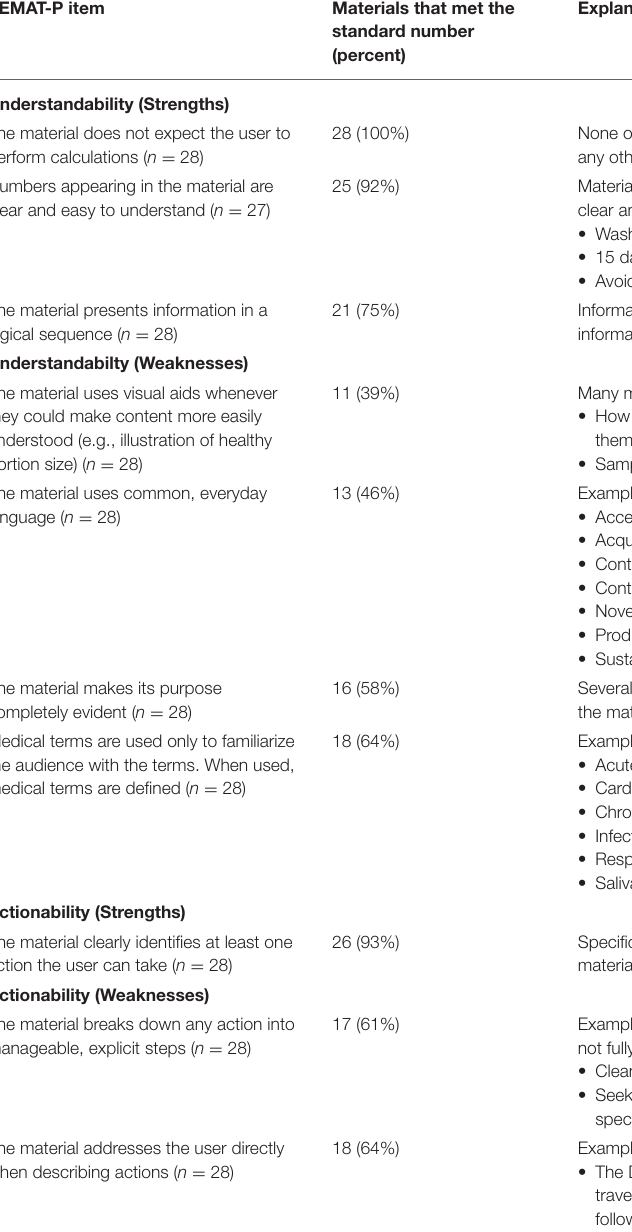
TABLE 1 | Selected PEMAT-P scores and examples. PEMAT-P item Materials that met the